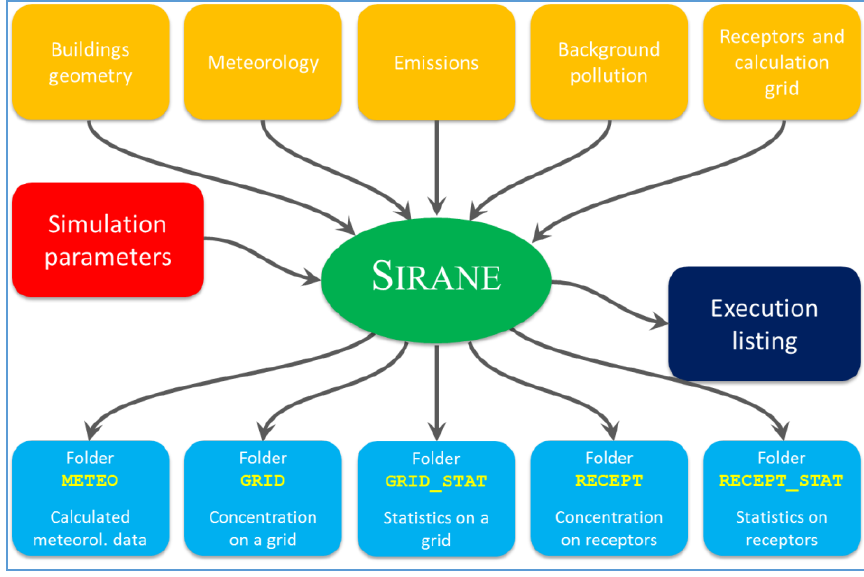
Figure 3. Graphical workflow of SIRANE.